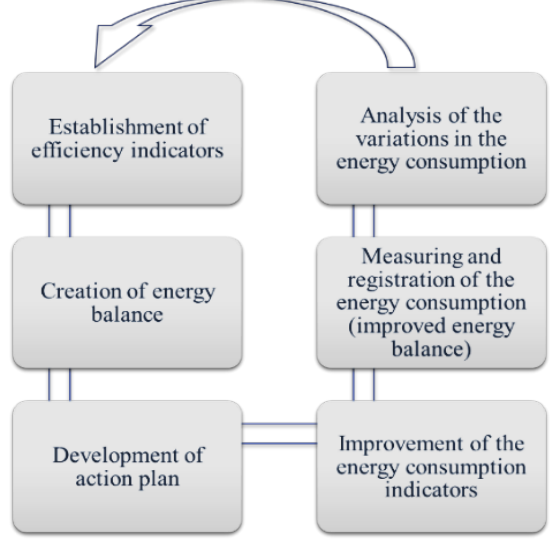
Fig. 3. Energy efficient process management system in public and residential buildings (developed by the